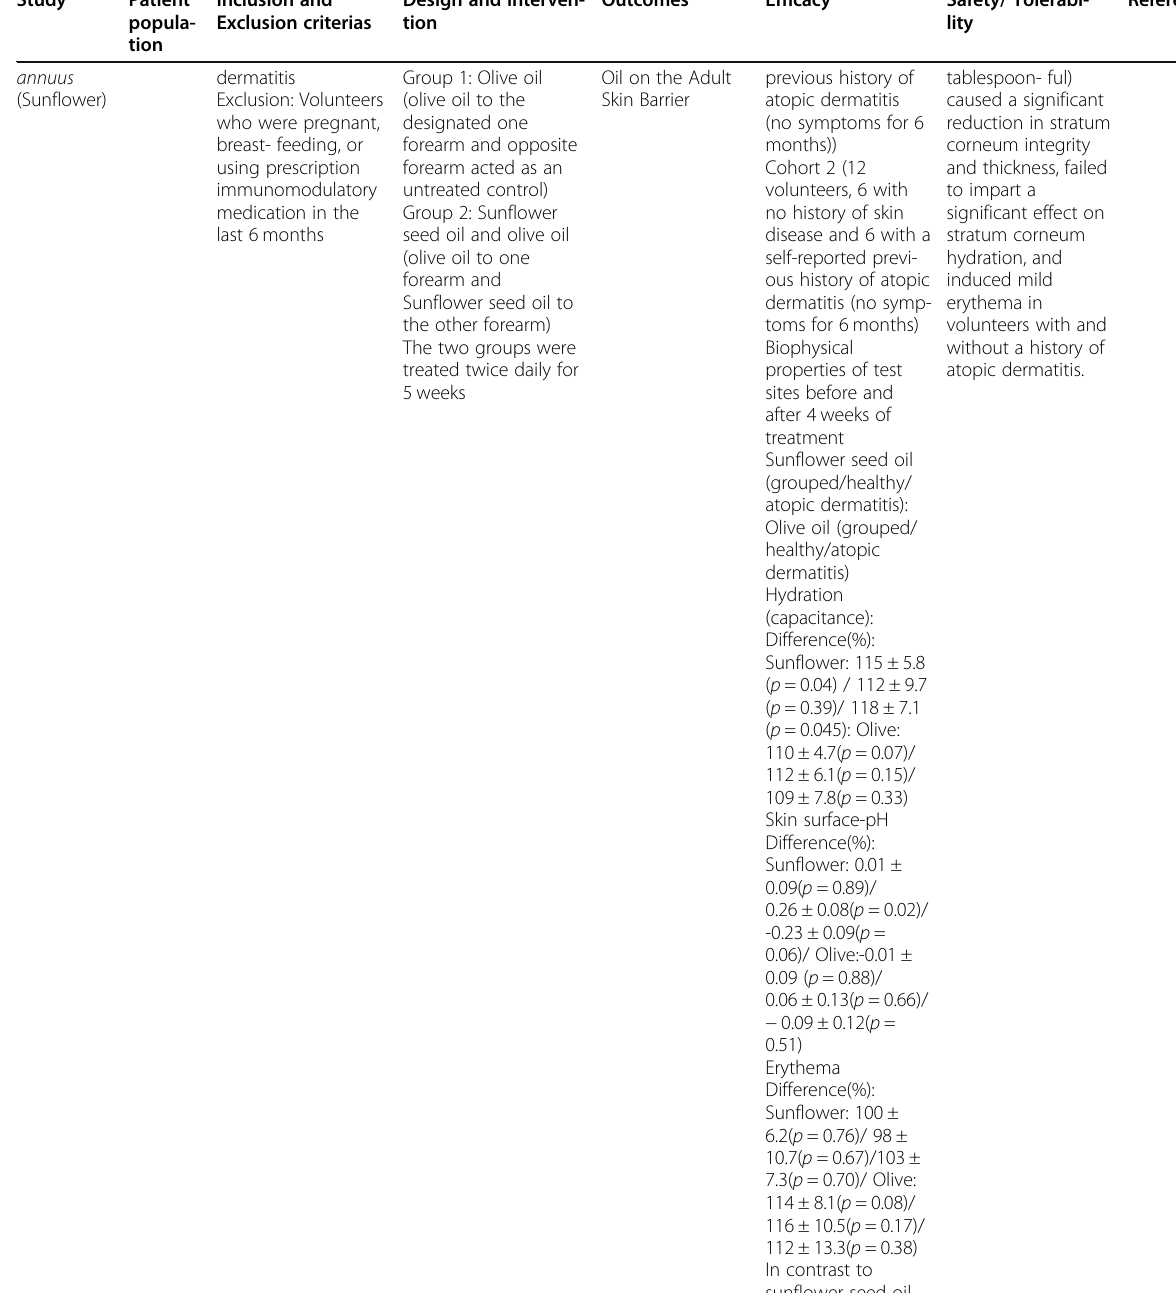
Table 4 Clinical trials of the traditional plants used for skin problems in Turkey (Continued)